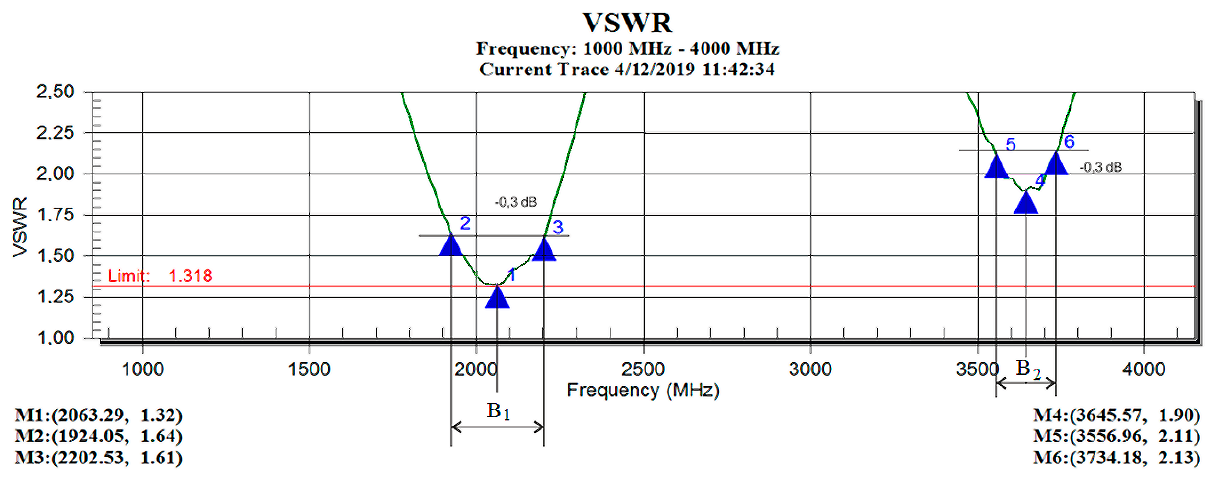
Figure 1. Measured antennas: ( a ) Illustration of cylindrical and flat antennas; ( b ) A dozen models produced of sets of antennas.